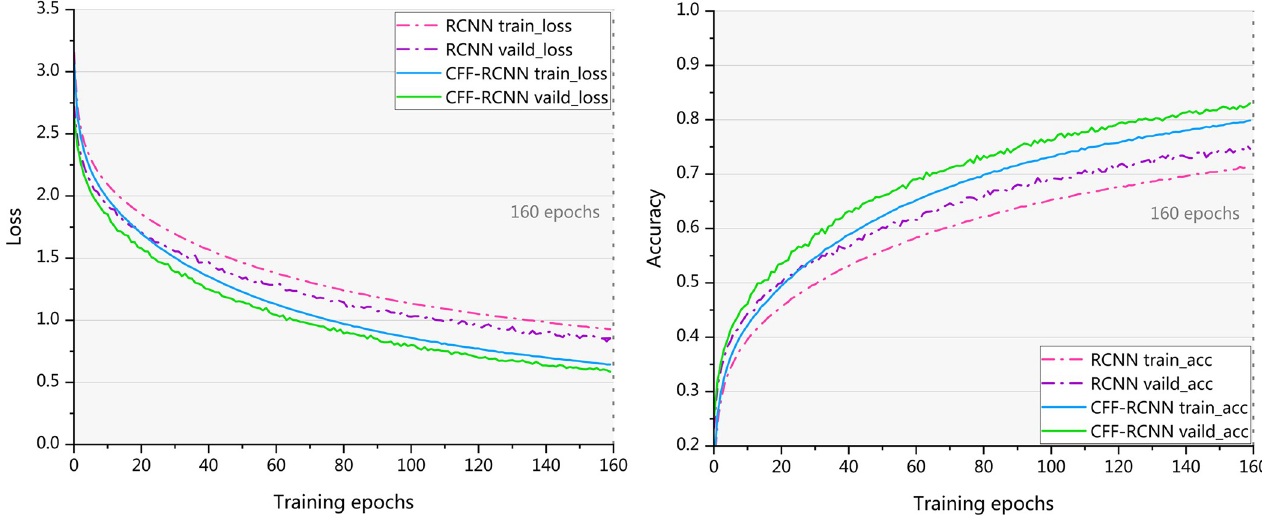
Fig 9. Loss and accuracy of the training and validation sets of the RCNN and CFF-RCNN on the total data of DB4.